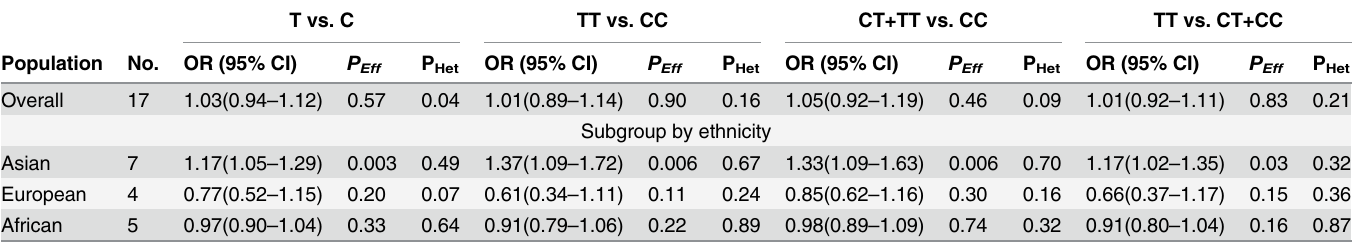
Table 4. Meta-analysis of the association between the IL-10 -819C/T polymorphism and TB. T vs. C TT vs. CC CT+TT vs. CC TT vs.